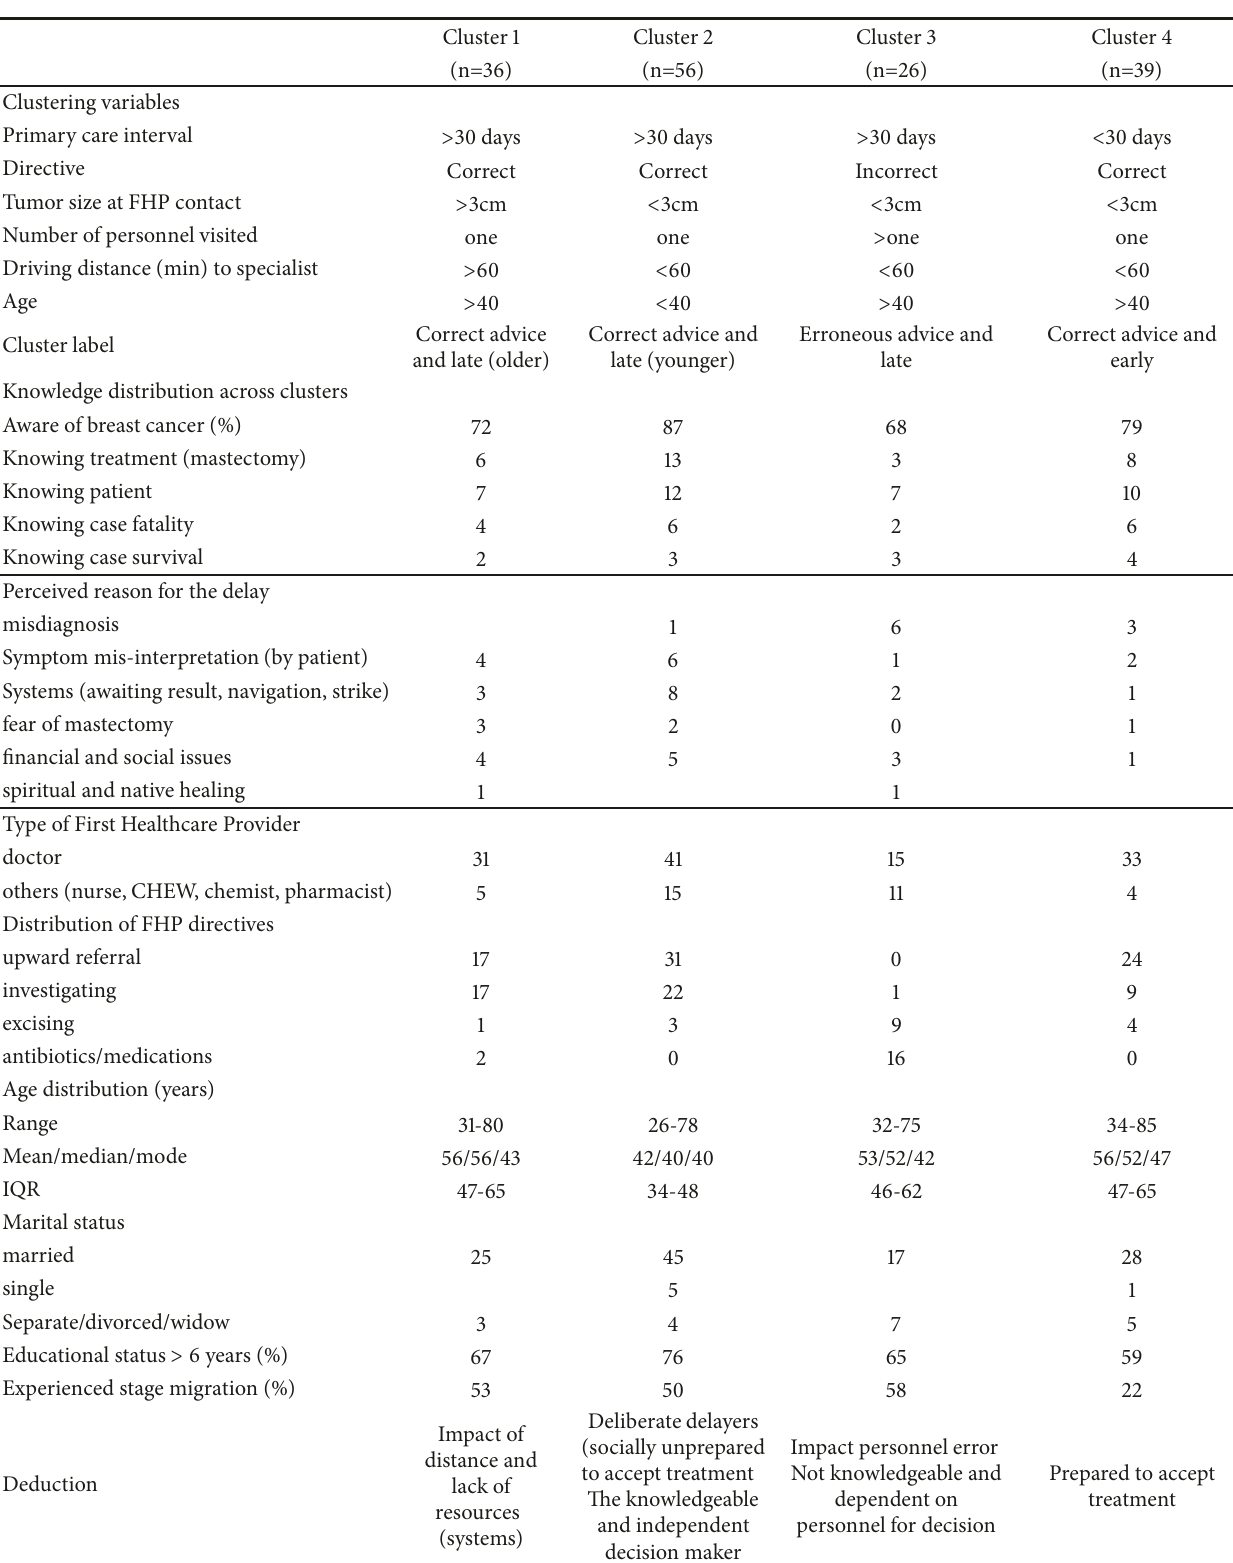
Table 4: Cluster characteristics: There were three subgroups with long primary care intervals (clusters 1-3) and one with short primary care interval (cluster 4). The majority of the patients were aware of breast cancer in all the clusters. The largest cluster was the deliberate